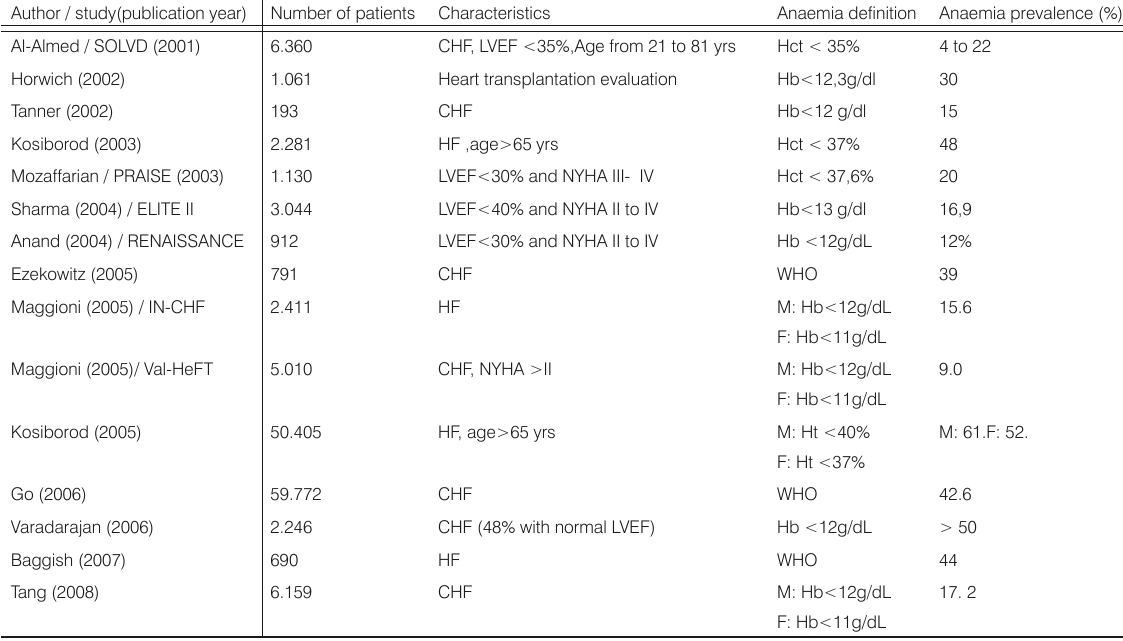
Table 1. Prevalence of anaemia in chronic heart